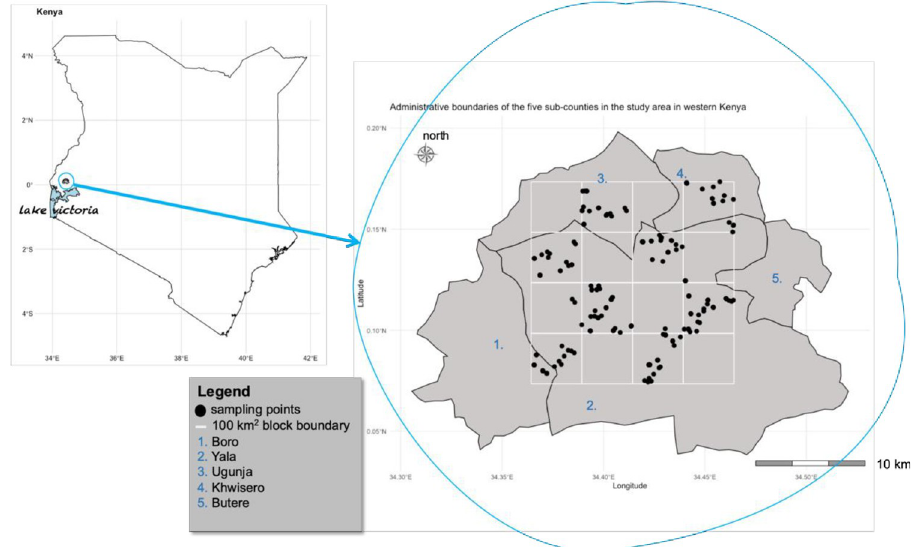
Fig 1. Geographical location of study site within sub-county administrative boundaries of Kenya, where the population-based farm survey was conducted, and also shows location sampled plots within maize field (blue